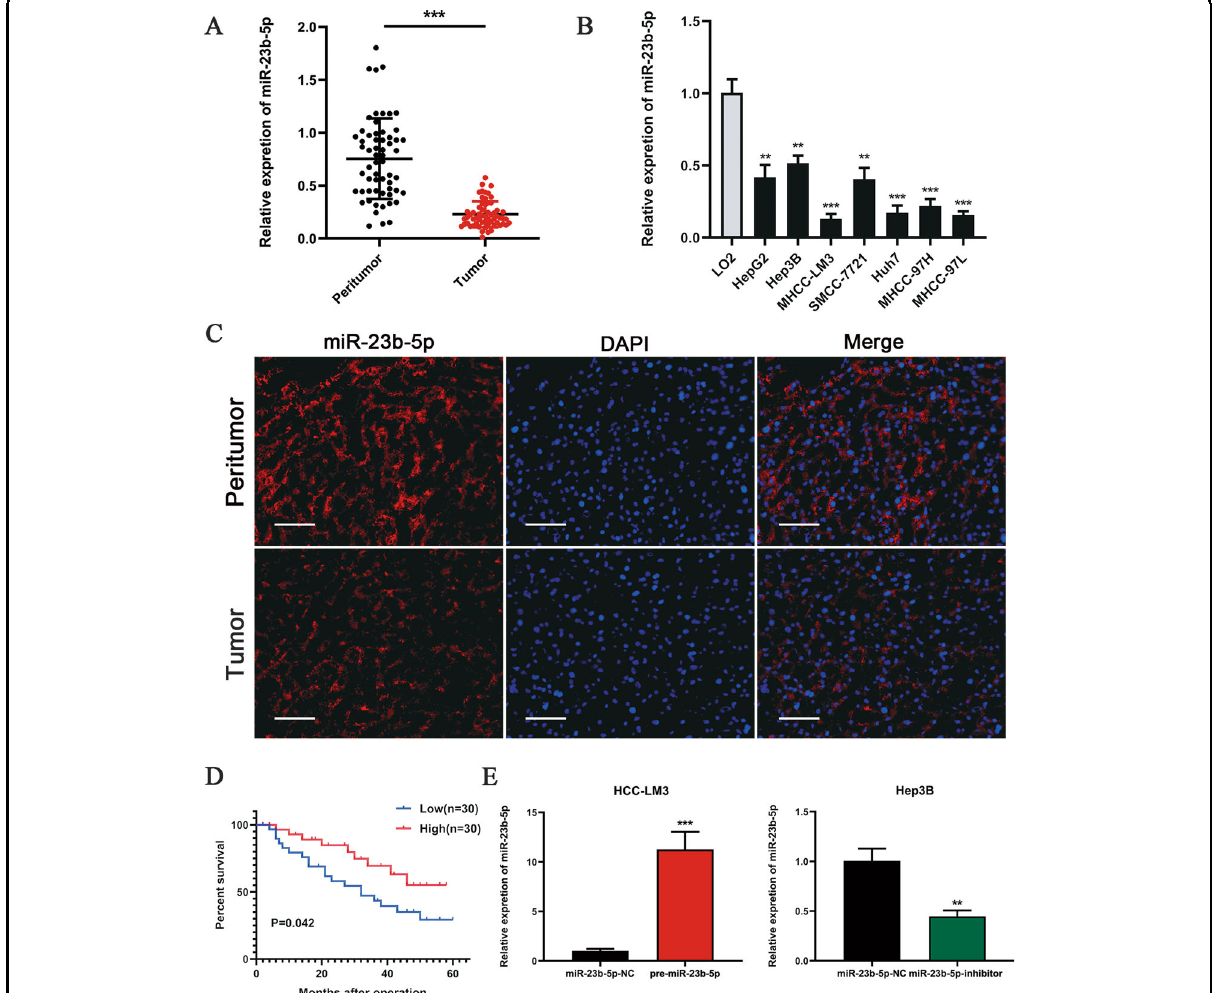
Fig. 1 miR-23b-5p is downregulated in HCC tissues and cell lines. A The mRNA levels of miR-23b-5p in 60-paired human HCC and adjacent normal tissues were tested by qRT PCR. B The mRNA levels of miR-23b-5p expression in HCC cell lines and normal LO2 cells. C Expression of miR-23b- 5p in HCC and adjacent normal tissues was measured by FISH assay (scale bars, 100 μ m). D Kaplan – Meier analysis for overall survival of 60 patients with HCC resection according to the miR-23b-5p expression. E The HCC-LM3 and Hep3B cells were transfected with lentivirus overexpressing miR- 23b-5p (pre-miR-23b-5p) or lentivirus with short hairpin RNA targeting miR-23b-5p (miR-23b-5p-inhibitor). Cells transfected with empty lentiviral vectors served as a negative control (NC). The miR-23b-5p expression levels were analyzed by qRT-PCR. All data are presented as the mean ± S.E.M. (* P < 0.05, ** P < 0.01, and *** P <